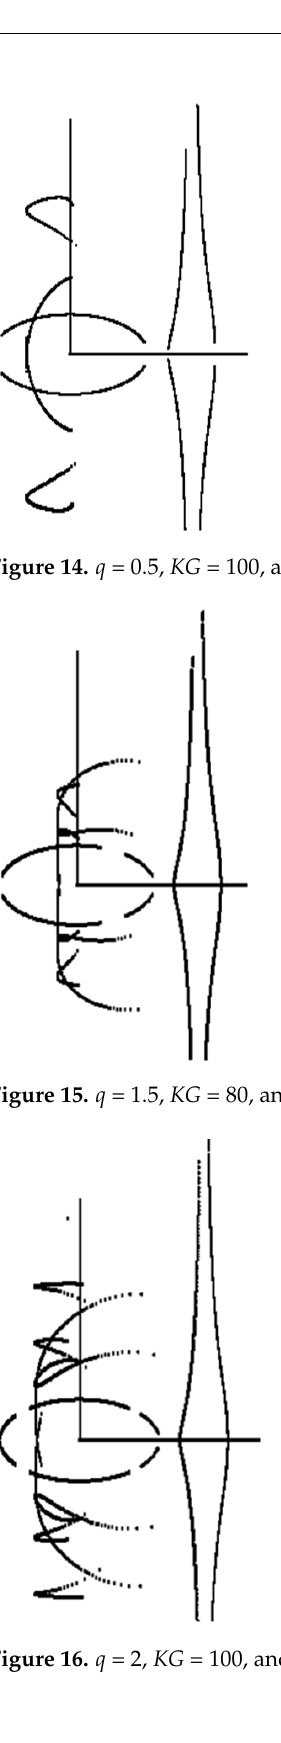
Figure 13. q = 1, KG = 130, and DK = 65